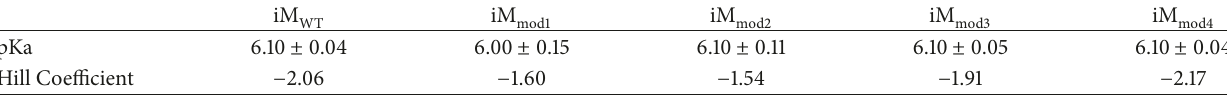
Table 2: Change in molar ellipticity (290 nm) of the electronic circular dichroism (ECD) spectra over the pH range of 5.0 to 8.1. ECD data was used to determine pK a using singular value decomposition (SVD) analysis of pH-dependent folding curves for each 5-hmC modified sample and compared to wild-type control. The Hill coefficient is the fitting parameter that characterizes the cooperativity of folding. iM